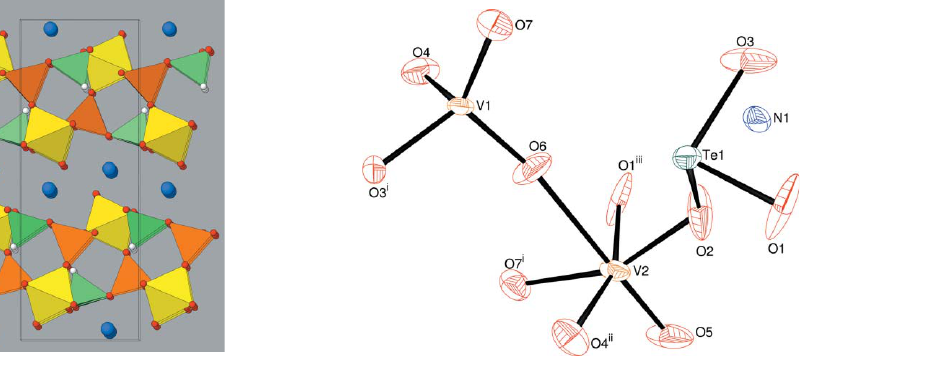
Figure 1 The asymmetric unit of (I) (50% displacement ellipsoids) expanded to show the coordination polyhedra of the V and Te atoms; see Table 1 for symmetry